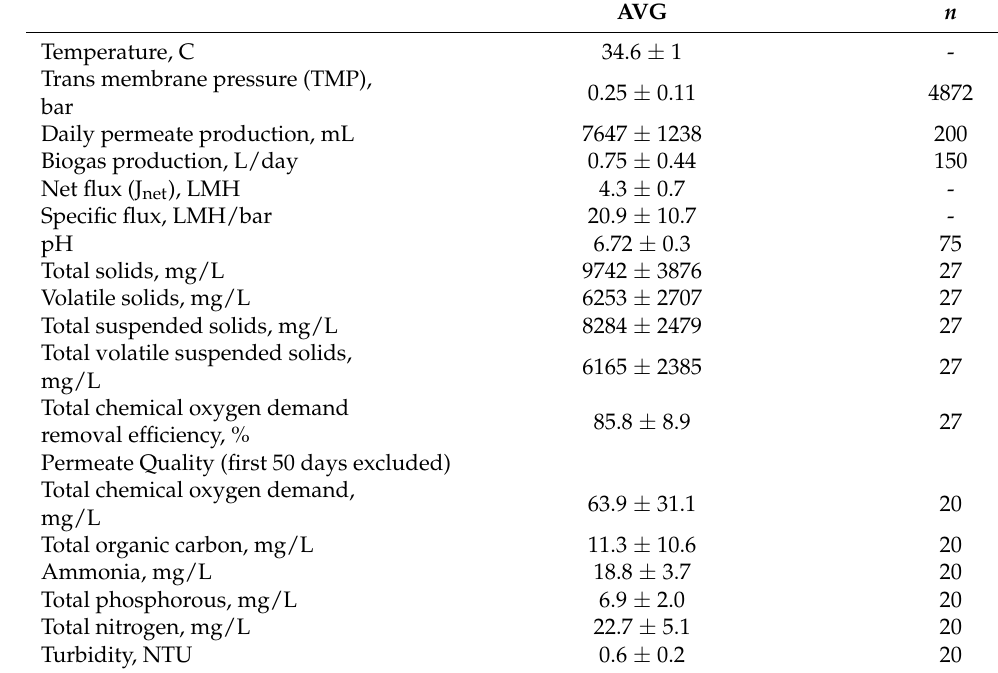
Table 2. Summary of average performance data of upflow anaerobic membrane